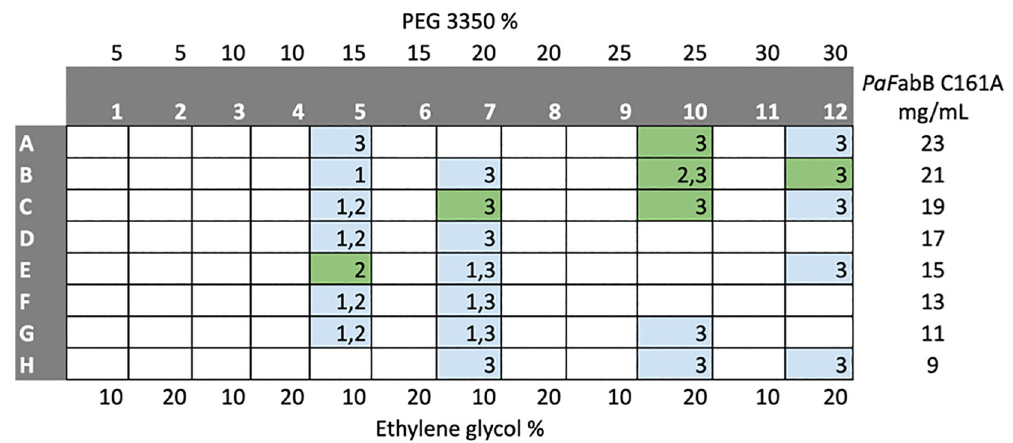
Figure 5. Plate layout for optimization of crystallization conditions. The numbers in the cells indicate the ratio between protein solution and crystallization buffer in the drops (drop 1-1:1 ratio, drop 2-1:2 ratio, drop 3-2:1 ratio). Coloured cells indicate conditions from which crystal were harvested and mounted for diffraction experiments. Green cells indicate conditions under which diffracting crystals were